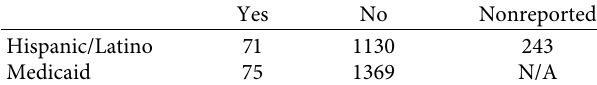
Table 1: Ethnicity and Medicaid coverage of the patients.